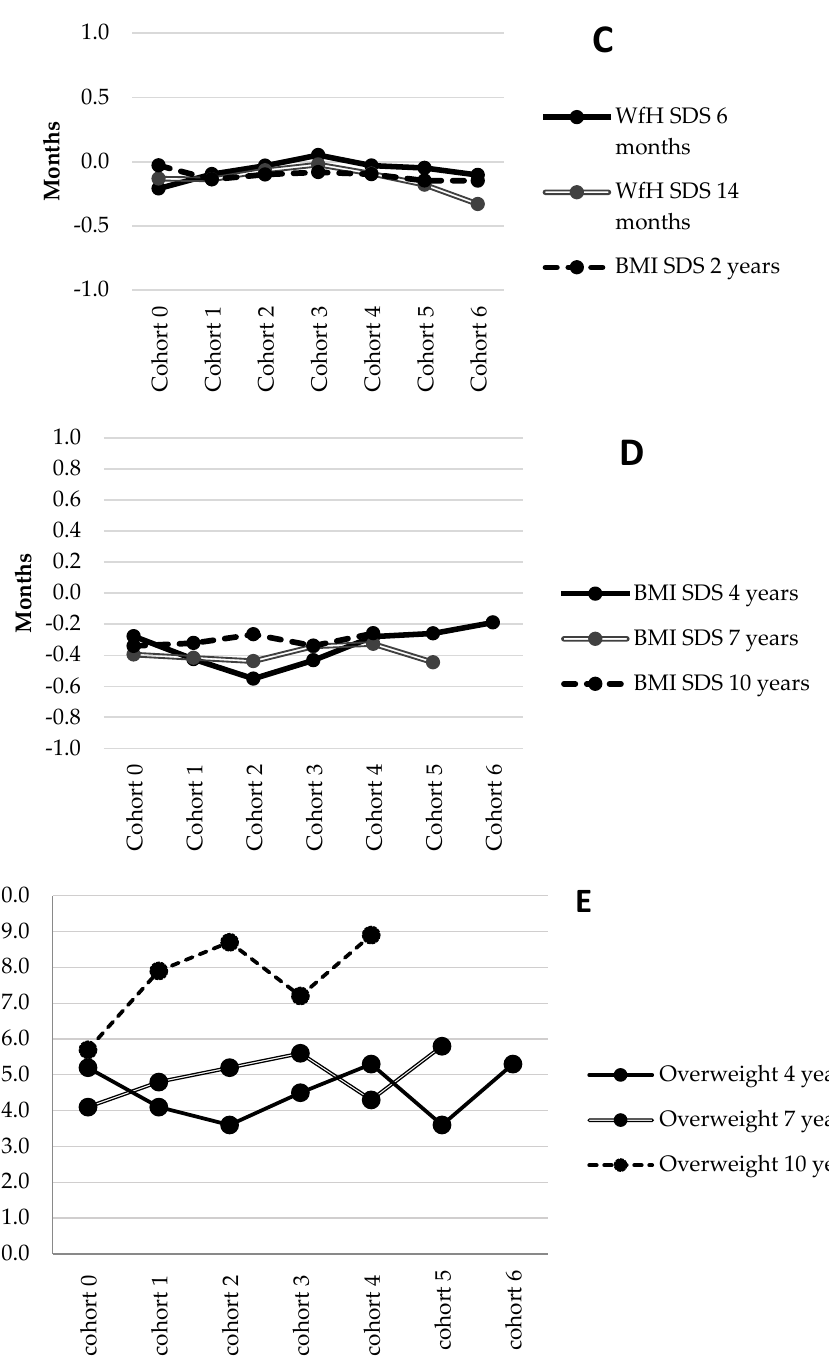
Figure 1. Cohort-specific means and standard deviations for motor milestones ( A ) rolling, sitting, crawling, ( B ) standing, walking, and speaking the first word, ( C ) WfL SDS age 6, 14 months and BMI SDS at 2 years, ( D ) BMI SDS at 4, 7, and 10 years, and ( E ) prevalence overweight at age 4, 7, and 10 years in twins from the Netherlands Twin Registry (NTR).